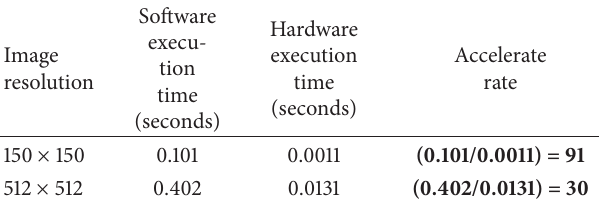
Table 1: Runtime comparison between acceleration rates of our proposed hardware implementation of anisotropic diffusion filter for different image